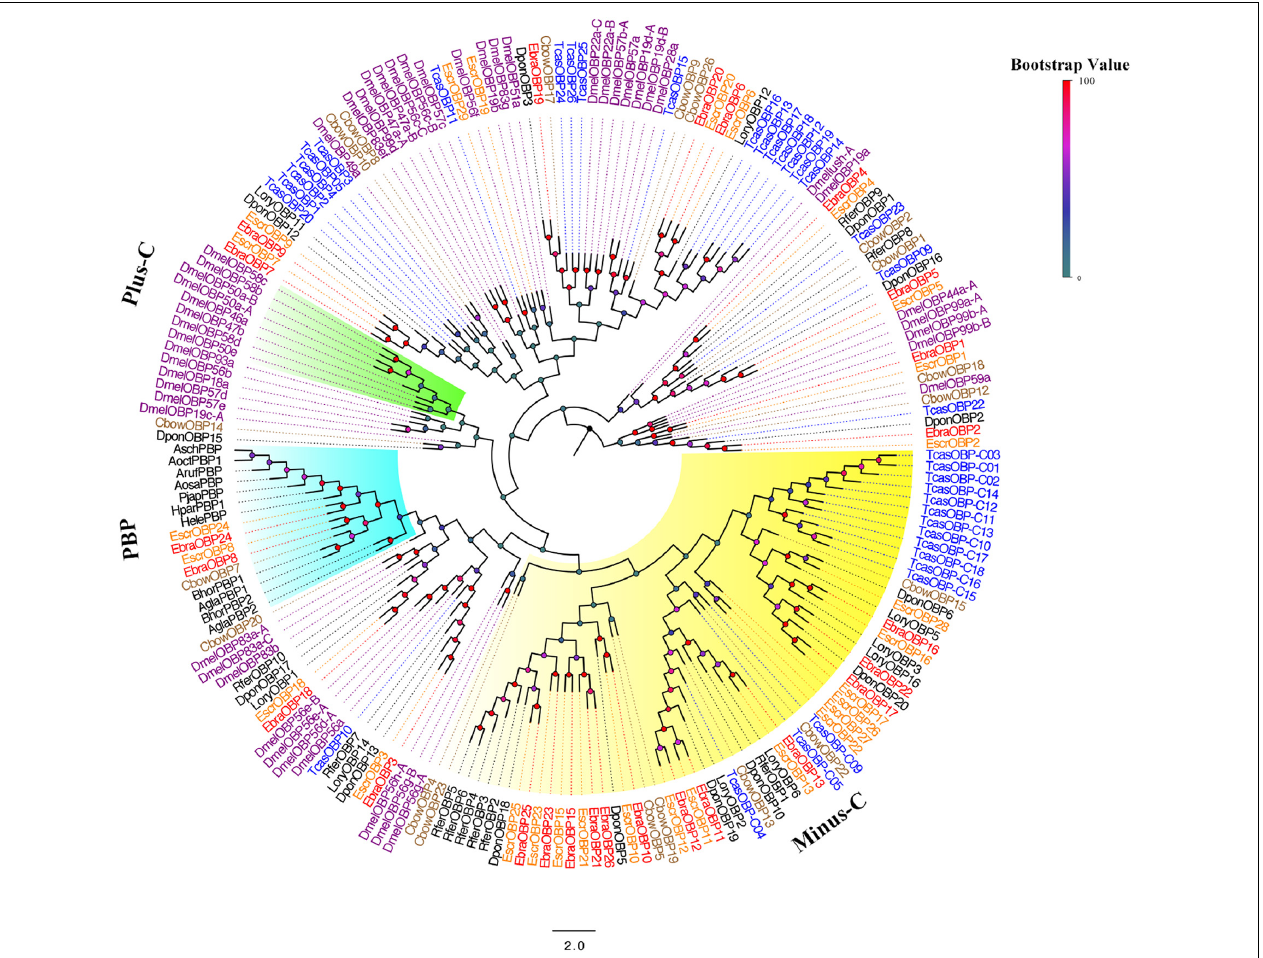
FIGURE 2 | Phylogenetic tree of putative odorant binding protein (OBP) genes. The E. scrobiculatus genes are shown in yellow and E. brandti genes are shown in red. The tree was constructed using MEGA6 with Neighbor-joining method. Amino acid sequences used for the tree are listed in Supplementary Table S10 .